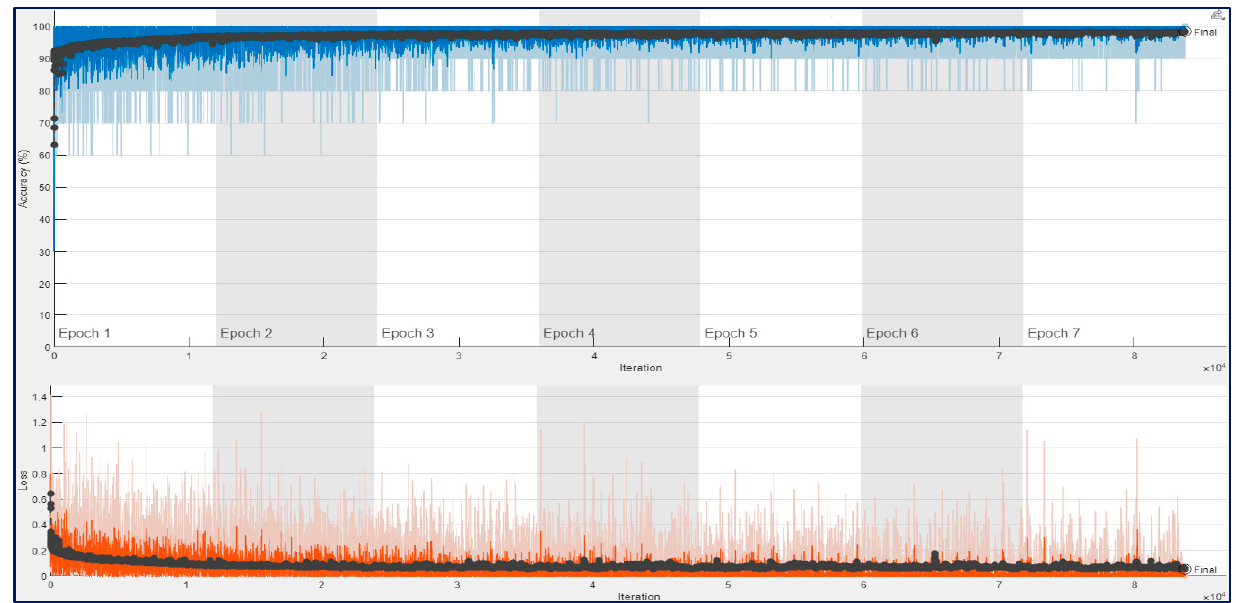
Figure 17. Training process result for ResNet50 with 132,968 spectrogram images in a trial on the 10 ‐ FCV.